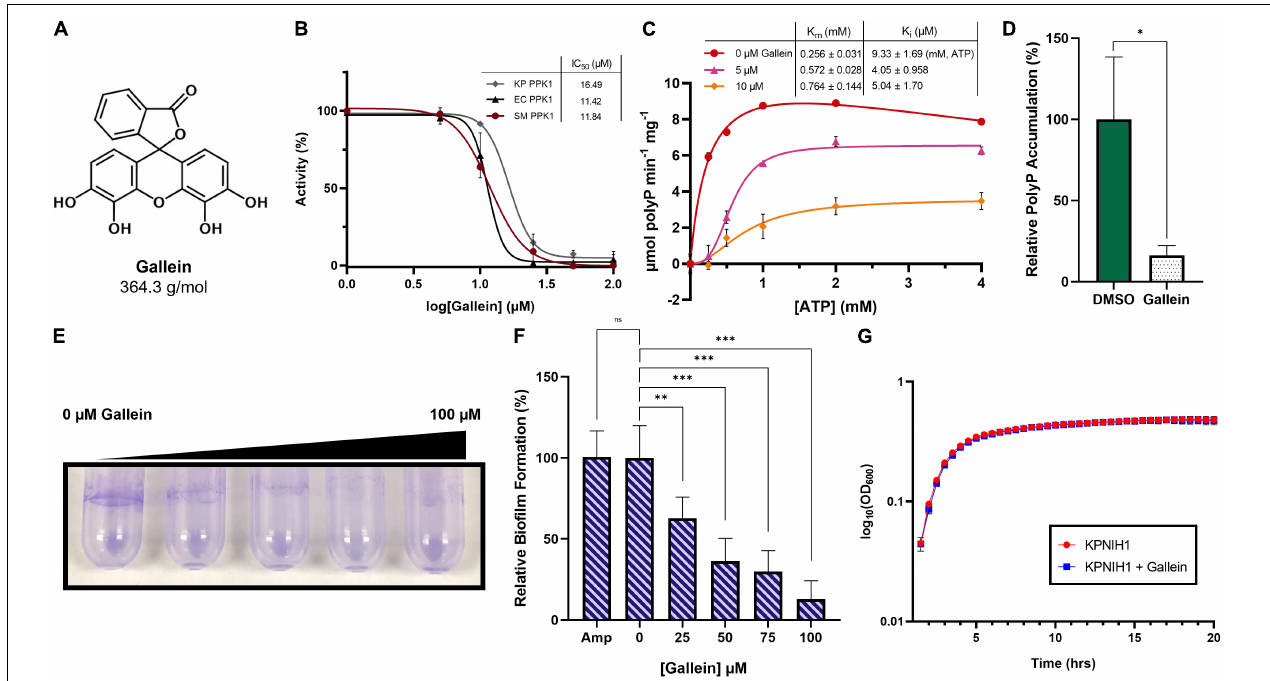
FIGURE 1 | Gallein inhibits Enterobacteriaceae PPK1s in vitro , and reduces intracellular polyP accumulation, biofilm formation in K. pneumoniae . (A) Chemical structure of gallein. (B) Dose-dependent inhibition of polyP synthesis by purified PPK1 enzymes from Klebsiella pneumoniae (KP), Escherichia coli (EC), and Serratia marcescens (SM). (C) Enzyme kinetic analysis of K. pneumoniae PPK1. Units are reported in specific activity ( µ mol per min per mg PPK). Uninhibited curve fit using substrate inhibition model (V o = Vmax*[S]/(K m + [S]*(1 + [S]/Ki)) where S is substrate), while inhibited curves fit using sigmoidal model (V o = Vmax*[S]ˆh/(K m ˆ h + [S]ˆh), where S is substrate, and h is the Hill coefficient). (D) Effect of 100 µ M gallein treatment on starvation-induced intracellular polyP accumulation in K. pneumoniae . (E) Representative image of gallein treatment on K. pneumoniae biofilm formation. Image is representative of n = 3 assays. (F) Dose-dependent effects of gallein and 100 µ g/mL ampicillin on K. pneumoniae biofilm formation. (G) Growth kinetics in lysogeny broth of K. pneumoniae KPNIH1 in the presence or absence of gallein. Symbols are as follows: ns, p > 0.05; ∗ p < 0.05; ∗∗ p < 0.01; ∗∗∗ p < 0.001. For (D) , two-way Unpaired t -test, n = 3; for (F) , one-way ANOVA, Tukey’s multiple comparison test, n = 6, Amp n =